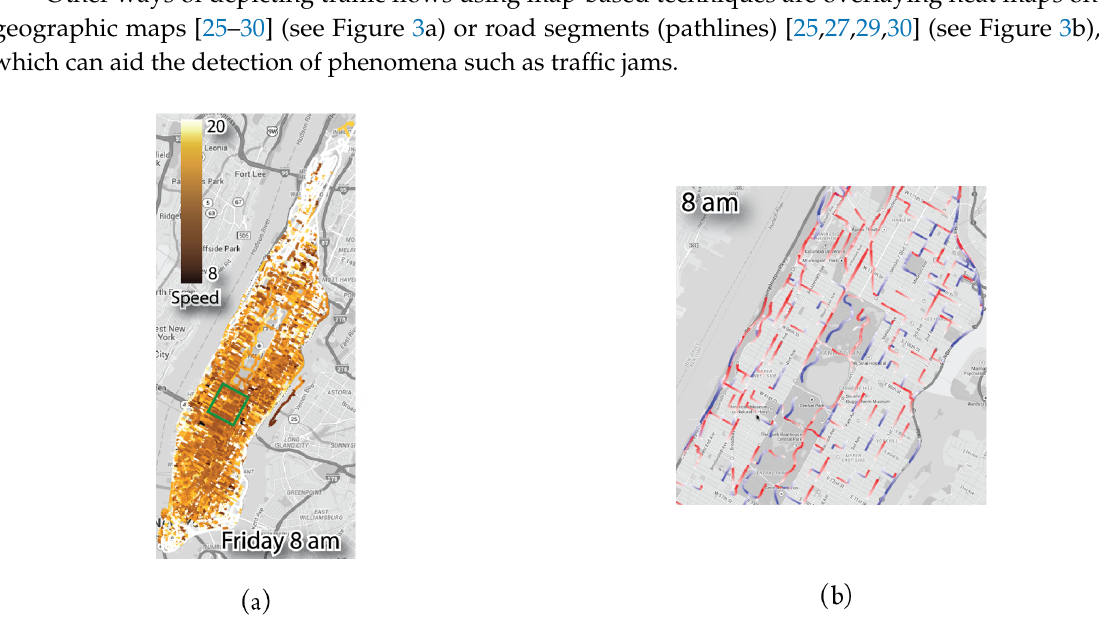
Figure 3. Other forms of representing heat maps on geographic maps. ( a ) consists of a heat map overlay, while ( b ) provides colors to road segments according to a given scale